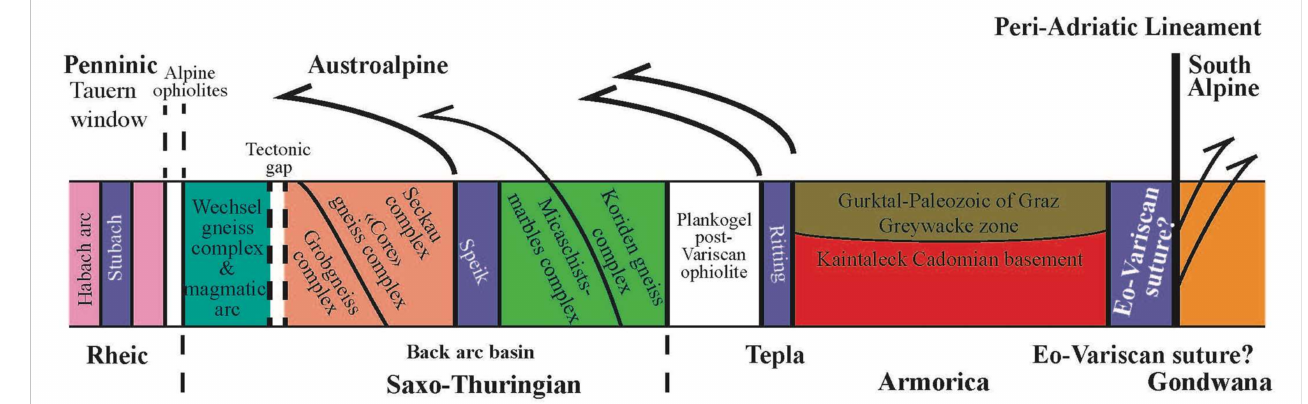
Figure 11. Tentative restoration of the Variscan belt by unravelling the litho-tectonic units involved in the Austroalpine nappe stack. The Speik ophiolite, interpreted as a back-arc basin, opened in a single continental terrane ascribed to the Saxo-Thuringian Domain. In spite of the Alpine tectonic gap, the Wechsel gneiss complex, interpreted as a magmatic arc, is also ascribed to the Saxo-Thuringian Domain. The Ritting ophiolitic suture separates Saxo-Thuringian and Armorican Domains. The South Alpine Variscan units are correlated to the Moldanubian Domain that belongs to the N. Gondwana margin. The Stubach ophiolite is ascribed to the Rheic